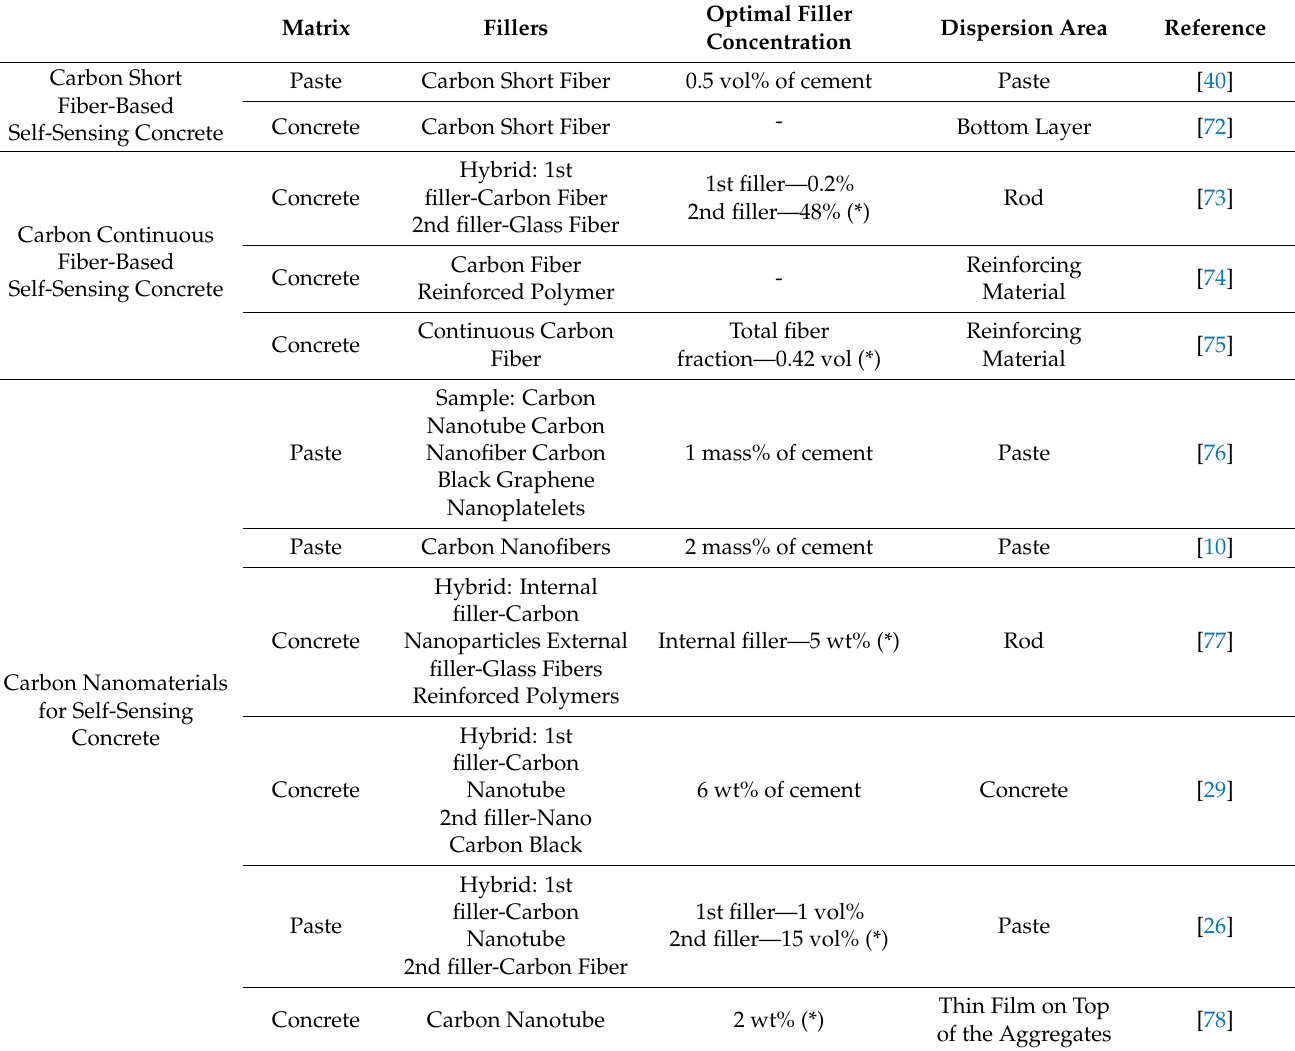
Table 4. Overview of different functional fillers covered in the literature.